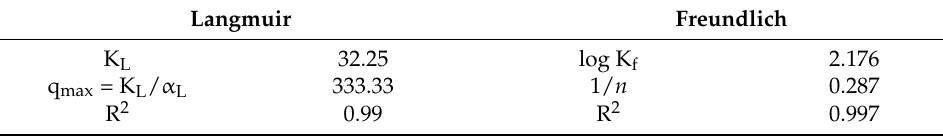
Table 2. Data from